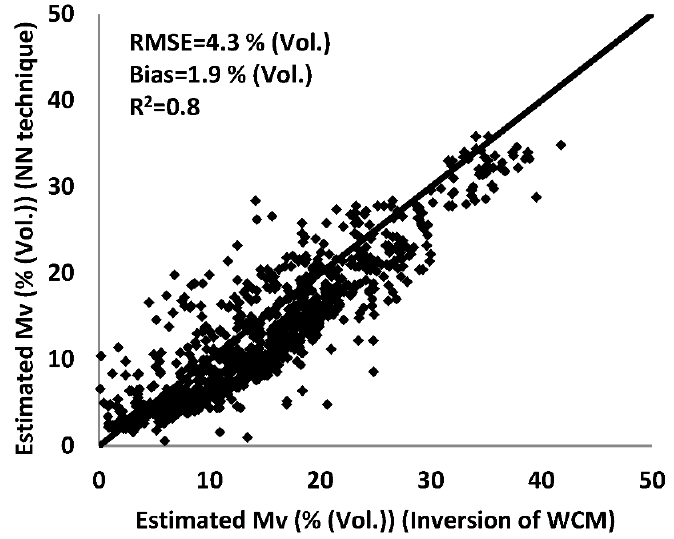
Figure 7. Comparison between WCM and Neural Network estimations of soil moisture.